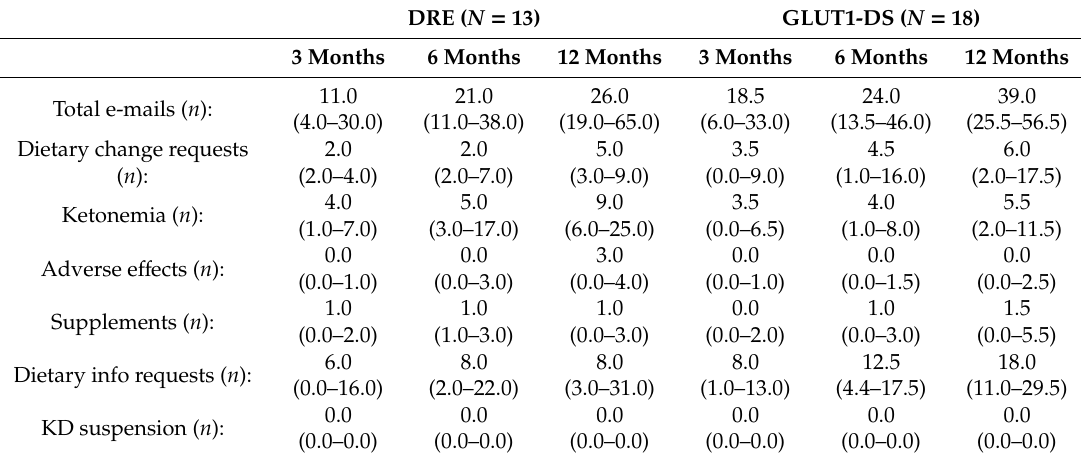
Table 3. E-mail monitoring in DRE and GLUT1–DS